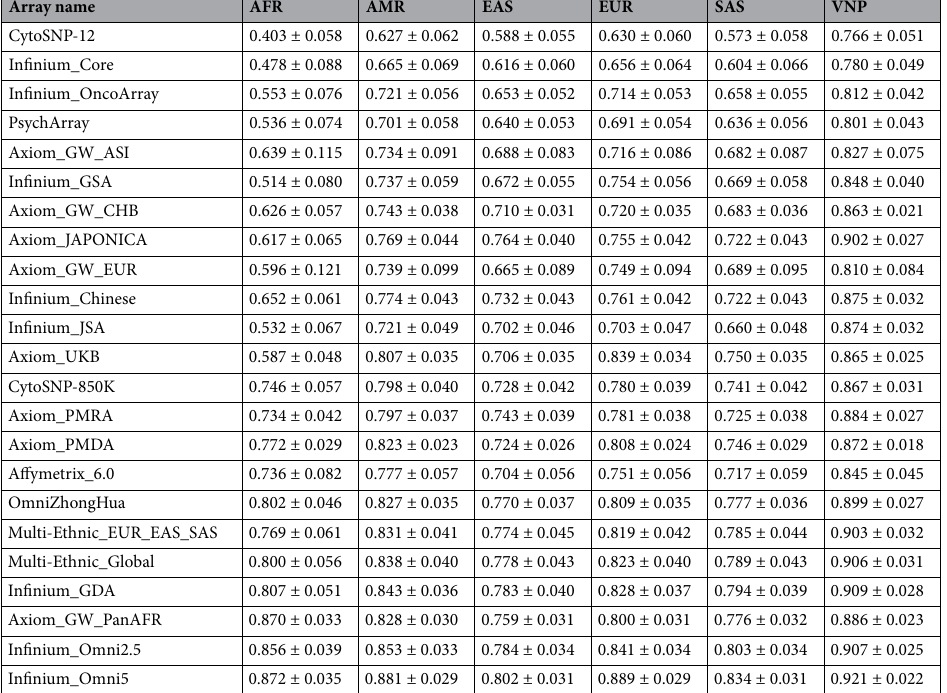
Table 3. Mean and standard deviation of imputation coverage (defined by the proportion of variants with r 2 ≥ 0.8 over total number of variants in each chromosome) measured in 22 autosomes at the MAF bin of